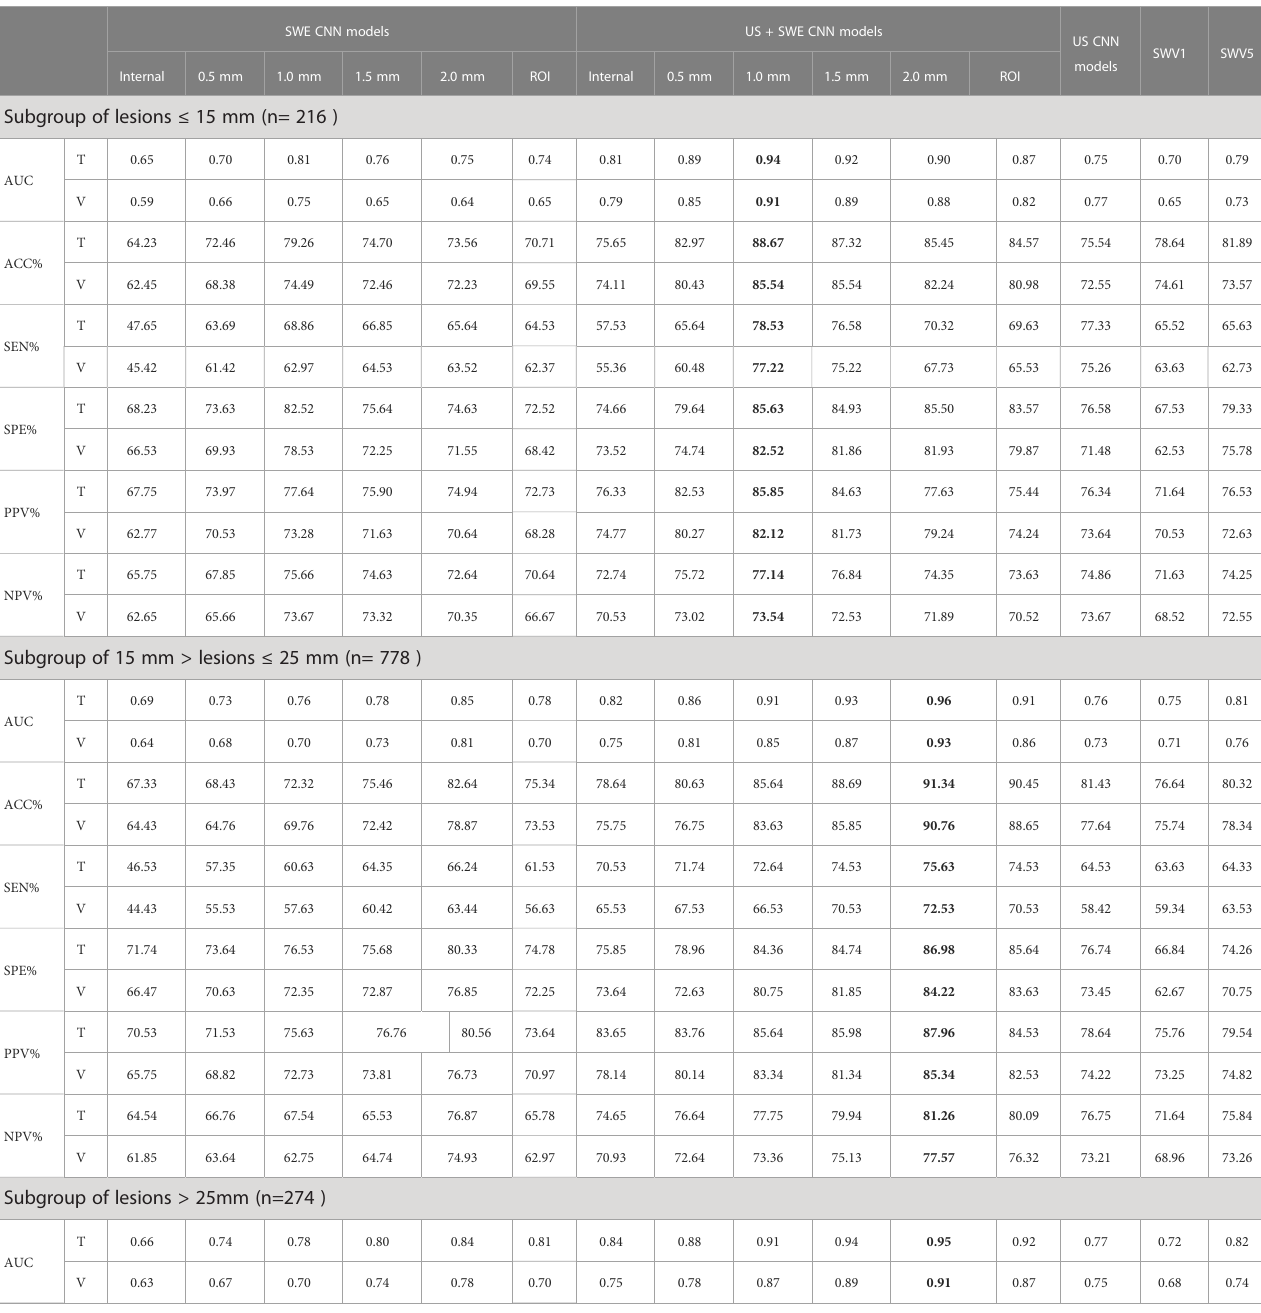
TABLE 4 Performance summary of SWE CNN model, US+SWE CNN models and quantitative SWE parameters for predicted breast cancer in the training and validation cohort.